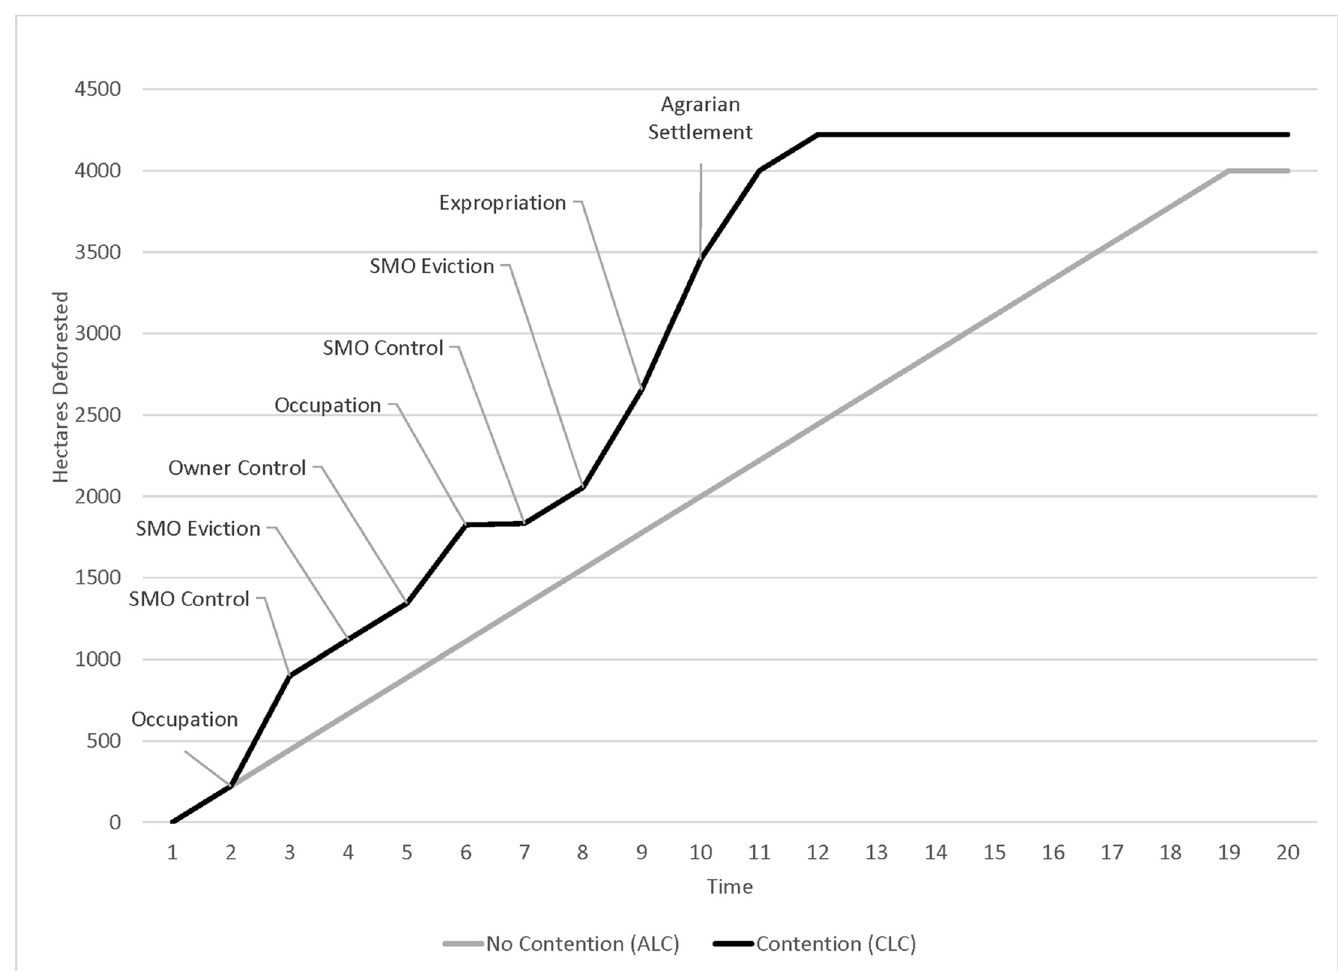
Fig 6. Average deforestation in hectares for properties with conflict and without